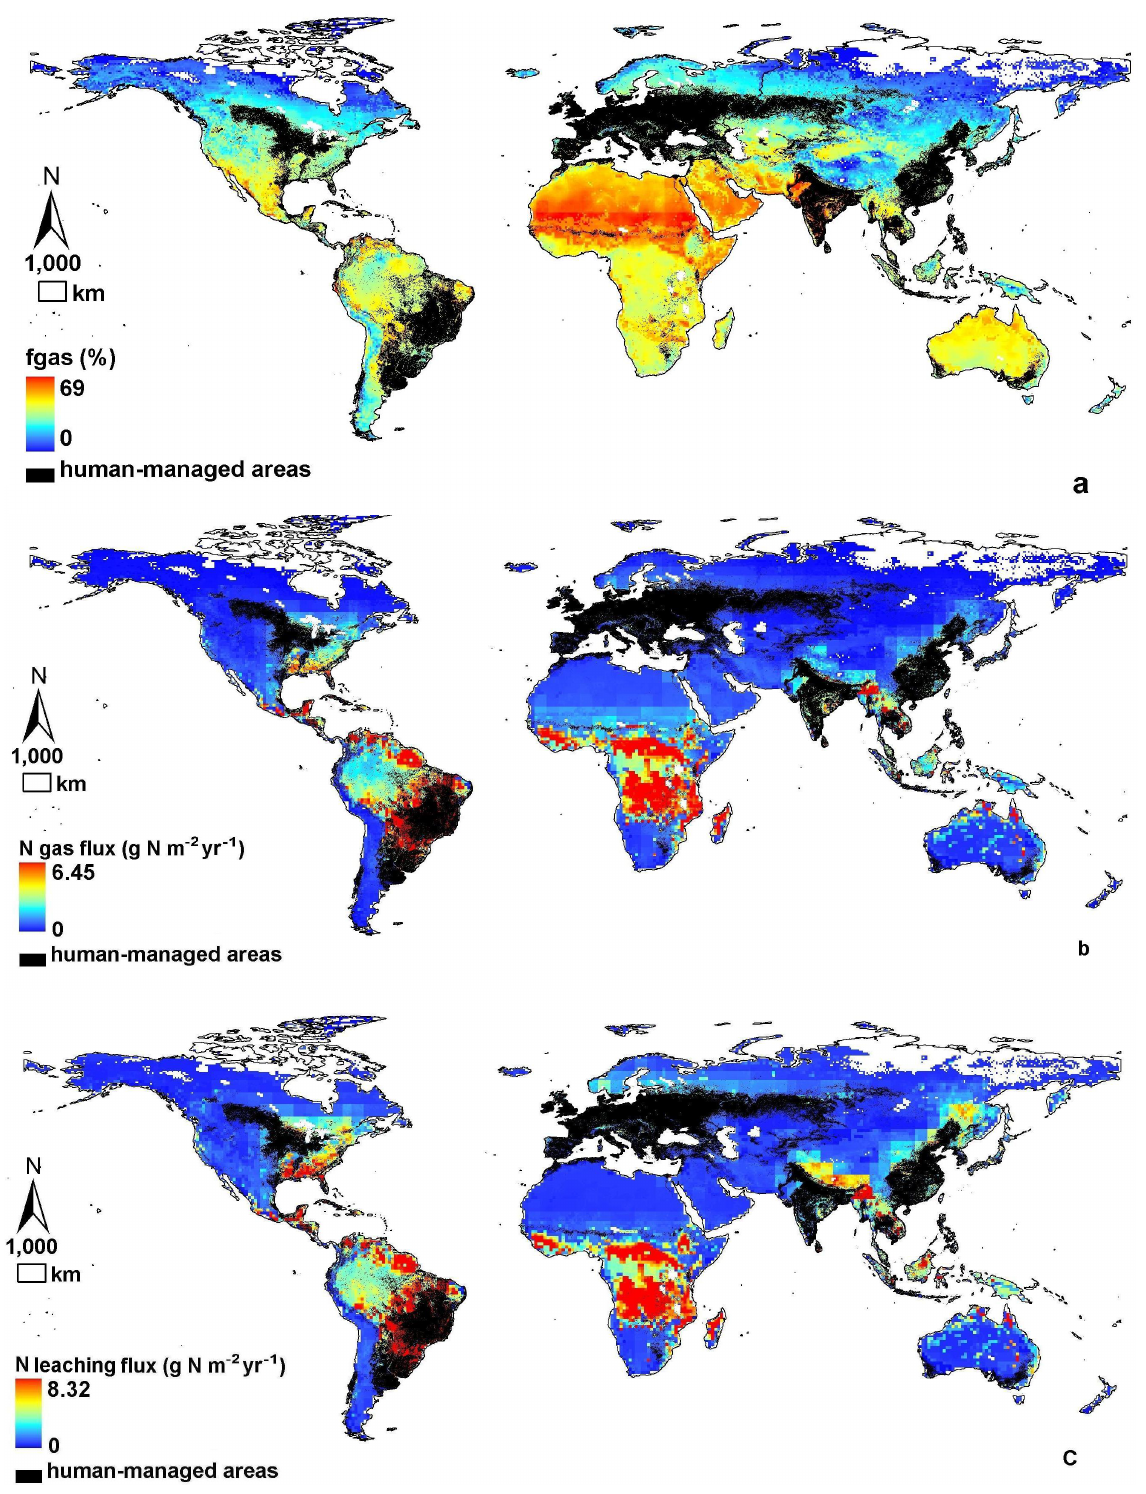
Fig. 7. Global patterns of fraction of gaseous N losses ( f gas ) (a) , total gaseous N flux (b) , and total leaching N flux (c) from unfertilized